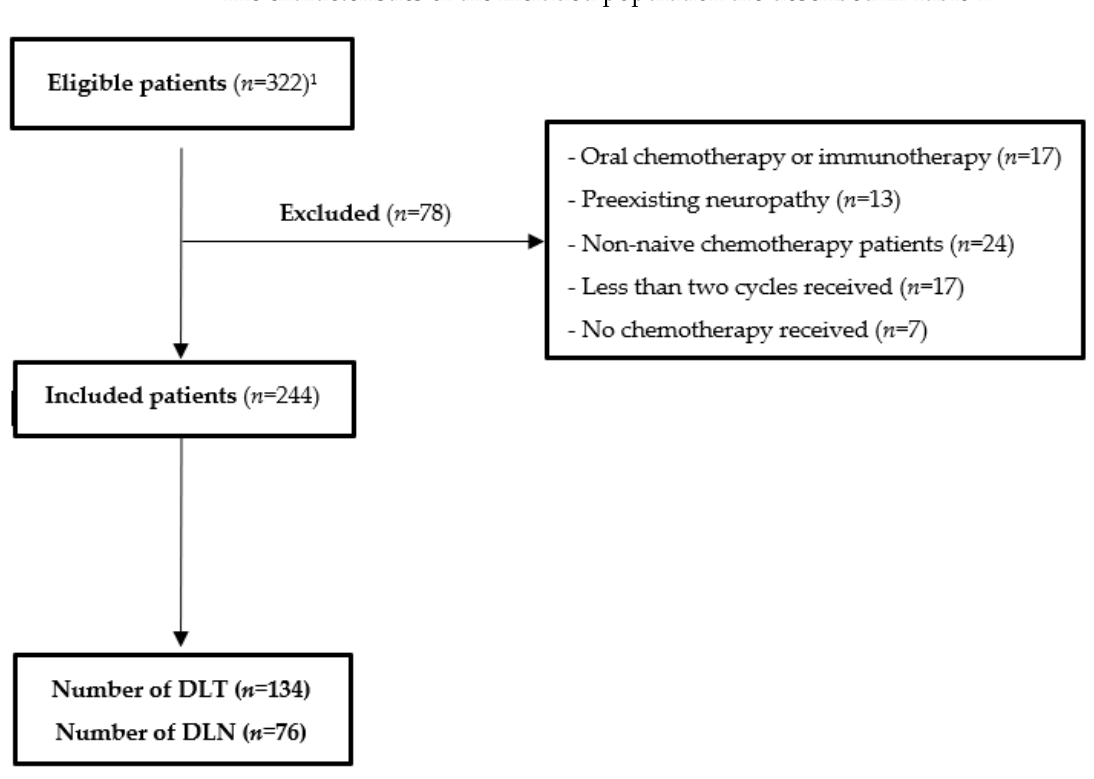
Figure 1. Flow chart of the FIGHTDIGOTOX study. Abbreviations: DLN: dose-limiting neurotoxicity; DLT: dose-limiting toxicity; UMA-CH, ambulatory cancer unit. 1 69 patients were assessed in AgElOn.